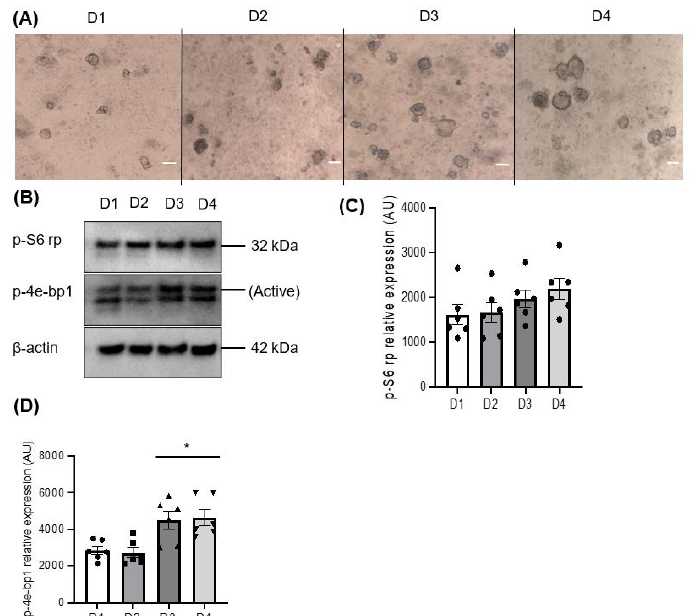
Figure 1. ( A ) Morphological appearance of salispheres at different time points; day 1 (D1), day 2 (D2), day 3 (D3), and day 4 (D4) of culture (scale bar = 20 µ m). ( B ) Immunoblotting of mTOR substrates; p-S6 rp and p-4e-bp1 at days 1, 2, 3, and 4 of culture showed active mTOR. ( C ) Densitometric analysis reveals a gradual but insignificant increase in the phosphorylation of S6 rp ( p = 0.2391). ( D ) A significant increase in the phosphorylation of 4e-bp1 was detected on days 3 and 4 compared to day 1 of culture (* p < 0.05). Data are expressed as mean ± S.E.M ( n = 6) in arbitrary units (AUs).